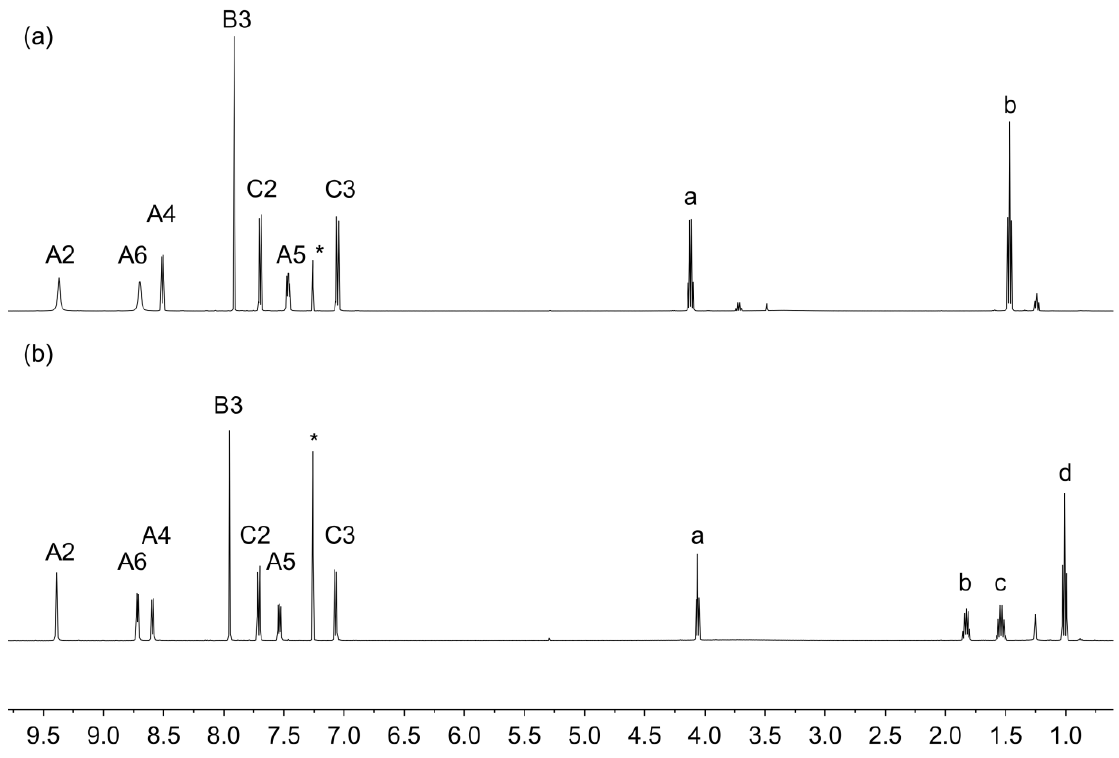
Figure 4. 1 H NMR spectra (500 MHz, CDCl 3 , 298 K) of ( a ) 5a and ( b ) 5c . See Figure 3 for the atom labelling scheme. * = residual CHCl 3 .